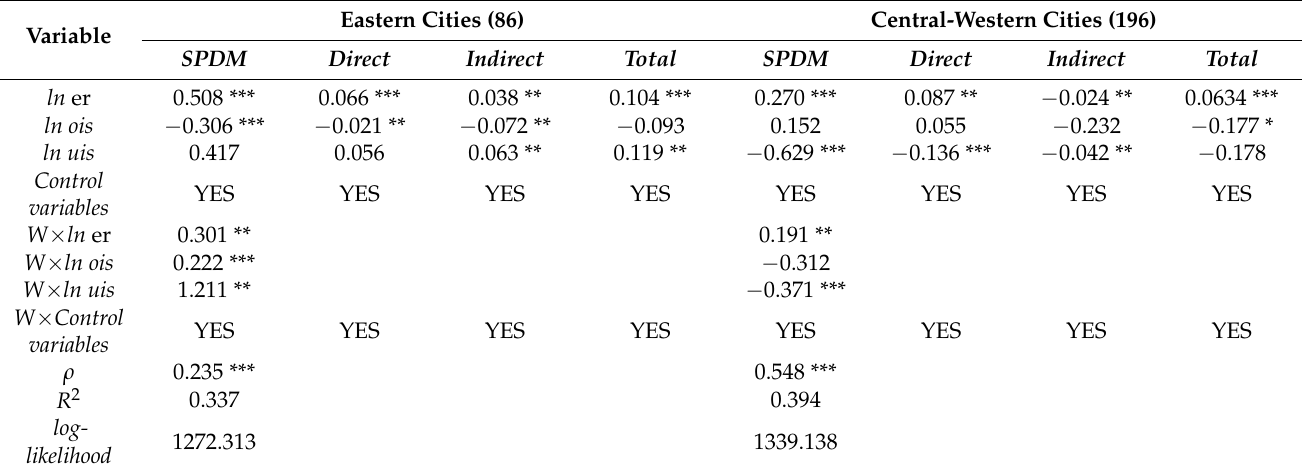
Table 4. The spillover effects of ER, OIS, and UIS on Urban low-carbon